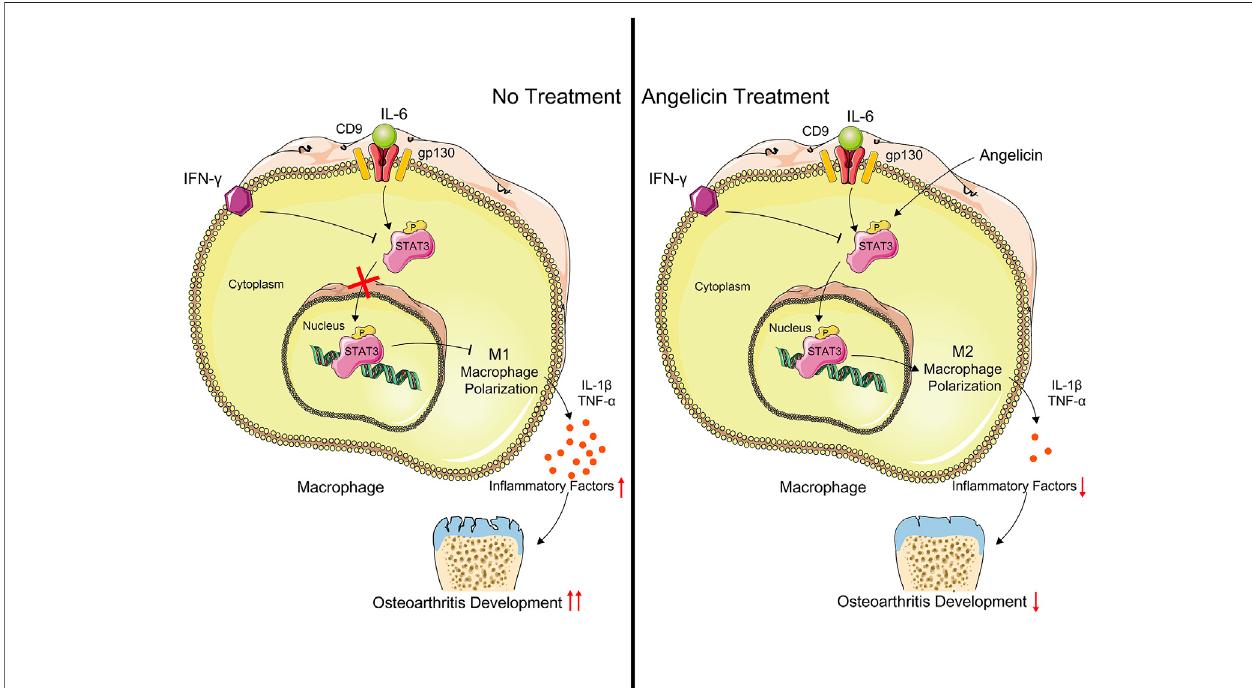
FIGURE 5 | Schematic illustration of the potential protective effects of angelicin in osteoarthritis development. Angelicin increased the phosphorylation of STAT3 and activated M2 macrophage polarization with the presence of LPS and IFN- γ .